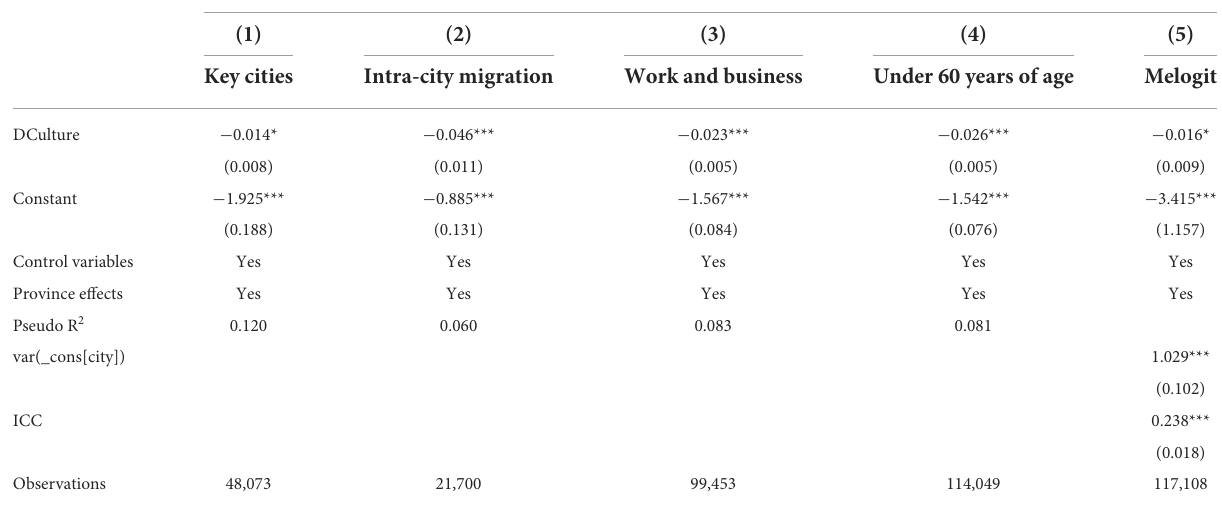
TABLE 4 Robustness test